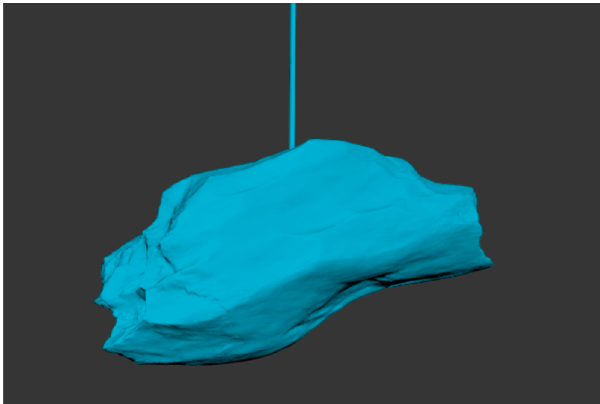
Figure 19. The three-dimensional model of the cave (h4).